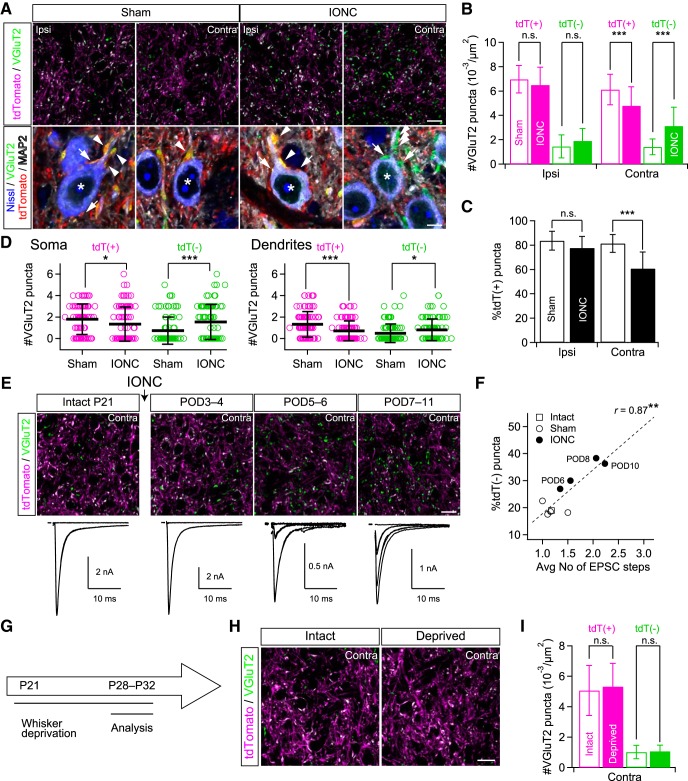
IONC increased non-PrV2-origin lemniscal fiber terminals in V2 VPM related to newly recruited lemniscal fibers onto VPM neurons. A, VGluT2-immunostained V2 VPM sections of Krox20-Ai14 mice. VGluT2 is a marker of lemniscal fiber terminals in the VPM. Top, Significant increase of tdT-negative (non-PrV2-origin) VGluT2 puncta in the contralateral V2 VPM after IONC. Scale bar, 20 µm. Bottom, The soma and dendrites of V2 VPM neurons were visualized by fluoro Nissl and MAP2 stainings, respectively, in addition to VGluT2 and tdTomato (top) to examine subcellular distribution of the VGluT2 puncta in their origin-specific manner. * indicates a V2 VPM neuron; arrows indicate somatic puncta; arrowheads indicate dendritic puncta. Scale bar, 5 µm. B, Summary density of VGluT2 puncta in the V2 VPM. tdT(+) = tdTomato-positive VGluT2; tdT(-) = tdTomato-negative ones. C, IONC decreased proportion of tdT(+) VGluT2 puncta in the contralateral V2 VPM. D, Summary numbers of VGluT2 puncta on the soma (left) and proximal dendrites (right) in the contralateral V2 VPM. tdT-positive puncta decreased whereas tdT-negative ones increased both on the soma and dendrites. A marker indicates each V2 VPM neuron examined. tdT(+) = tdTomato-positive VGluT2; tdT(-) = tdTomato-negative ones. E, Correlated postoperative time course of anatomic and functional lemniscal fiber remodeling in the V2 VPM. Top: VGluT2 immunostaining. Scale bar, 20 µm. Bottom: Discrete lemniscal fiber-mediated EPSCs in a V2 VPM neuron in response to increasing electrical stimuli on the medial lemniscal fiber bundle (Takeuchi et al., 2012). F, Correlation between anatomic and functional lemniscal fiber remodeling in the contralateral V2 VPM. r, Pearson’s correlation coefficient. Broken line is the regression line. G, Experimental schedule of whisker deprivation. H, VGluT2-immunostained sections of the V2 VPM in Krox20-Ai14 mice after whisker deprivation. Scale bar, 20µm. I, Summary density of VGluT2 puncta in the contralateral V2 VPM. tdT(+) = tdTomato-positive VGluT2; tdT(-) = tdTomato-negative ones. Values are represented as mean (±SD). Three to nine mice (eight images from each mouse) were analyzed for each group in A–I. In total, 94 neurons from four mice (4-10 neurons from each image) were analyzed for each group in D. In total, 215 neurons from 91 mice and 118 images from 14 mice were analyzed for E and F. Statistical significance was tested by two-way repeated measures ANOVA (main effect of IONC or whisker deprivation; B–D and I) and Pearson’s product-moment correlation test (F). *p < 0.05; **p < 0.01; ***p < 0.001; n.s., not significant; two-tailed.